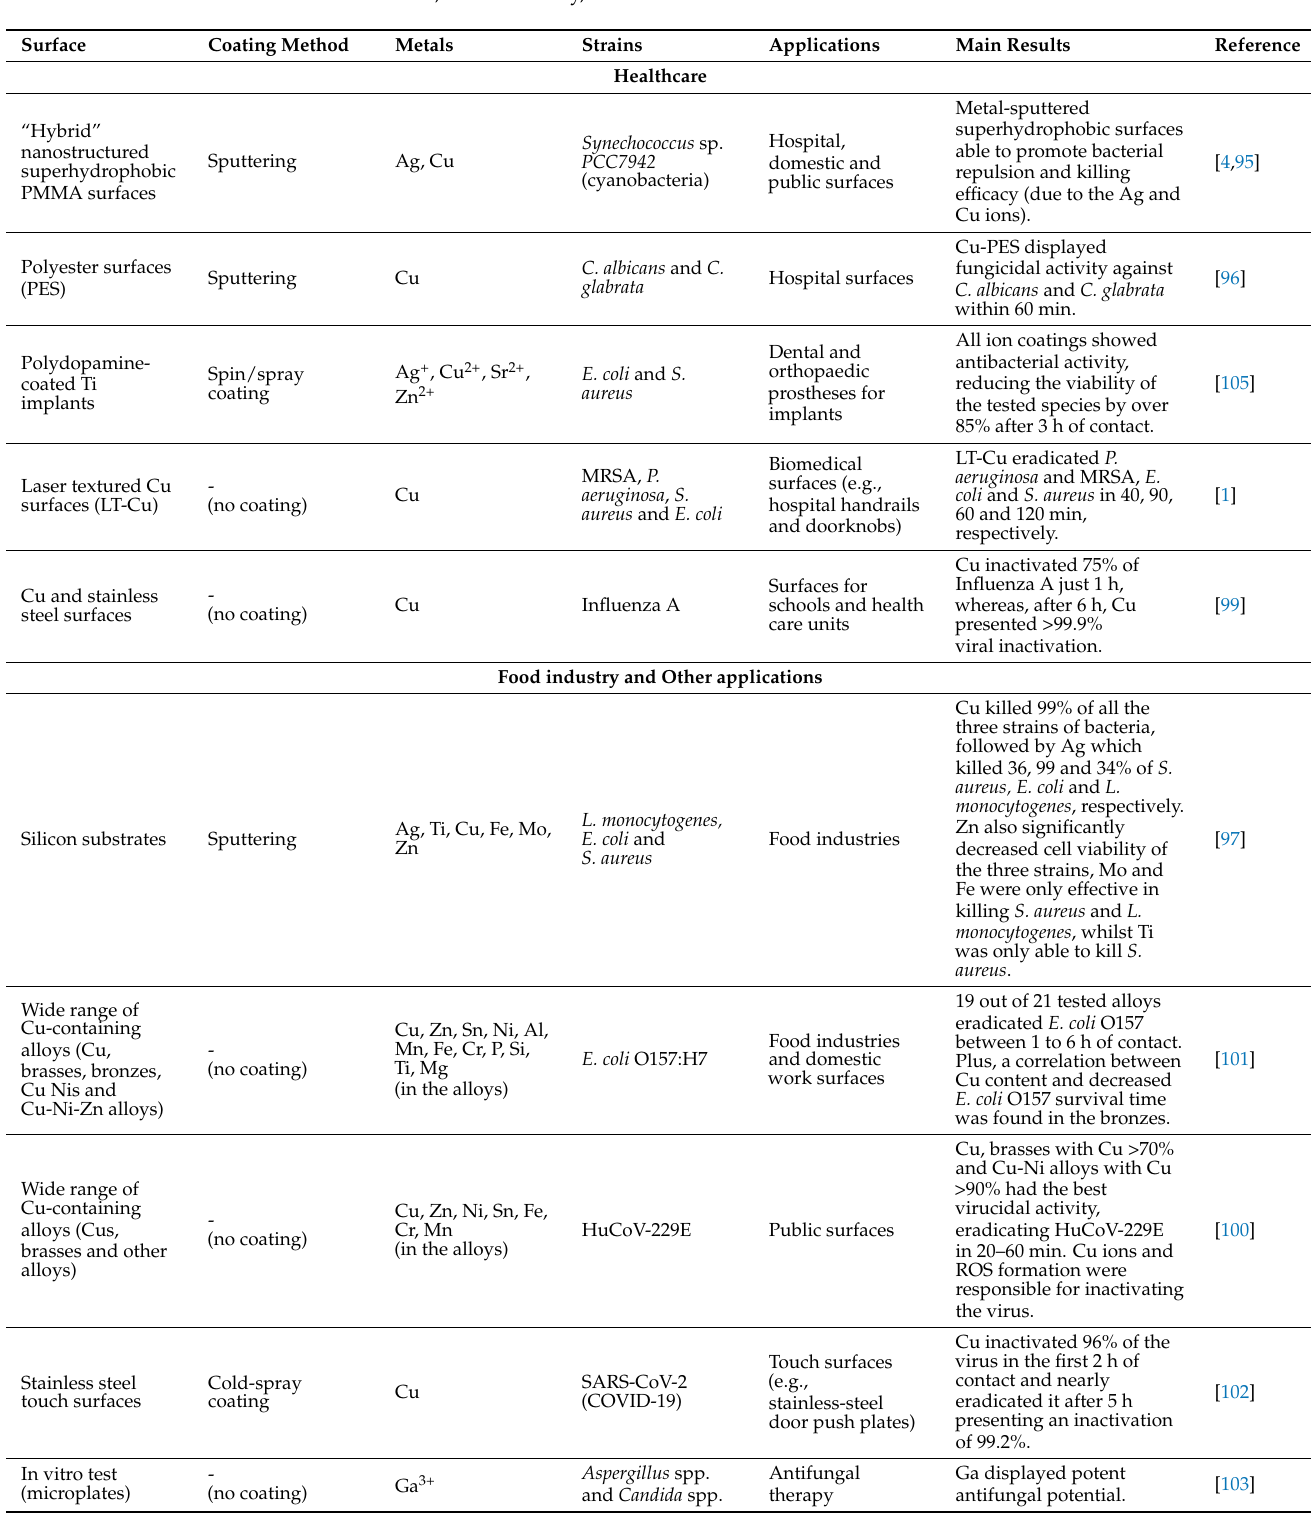
Table 3. Different approaches for the development of metallic antimicrobial surfaces to be applied in healthcare, food industry, and